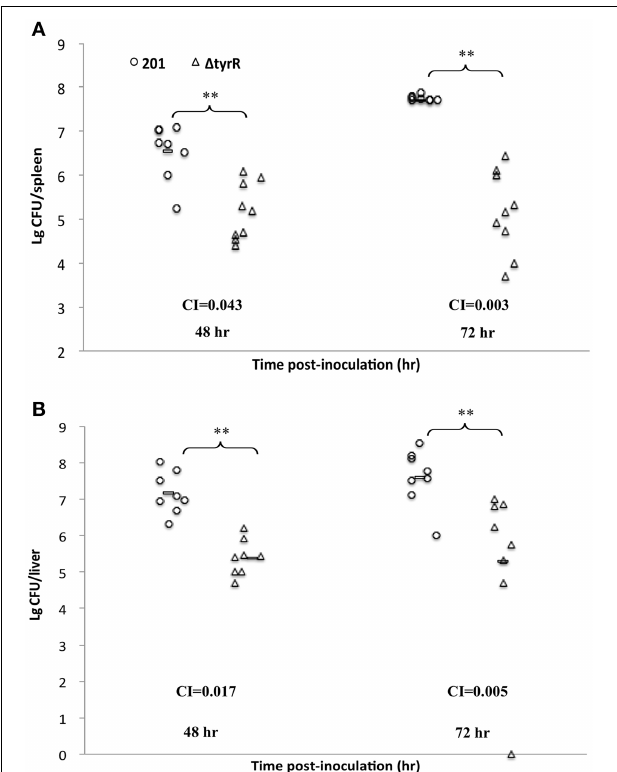
FIGURE 3 | Growth dynamics of Y. pestis upon inoculation by intraveneous route. Groups of eight mice were inoculated intravenously with bacterial mixture of Y. pestis strain 201 and the tyrR mutant. Bacterial loads of WT strain (open circles) and tyrR mutant (open triangles) in spleen (A) and liver (B) were determined at 48h and 72h post-inoculation. Horizontal bars indicate geometric means. The indicated P values were determined using the Student’s t